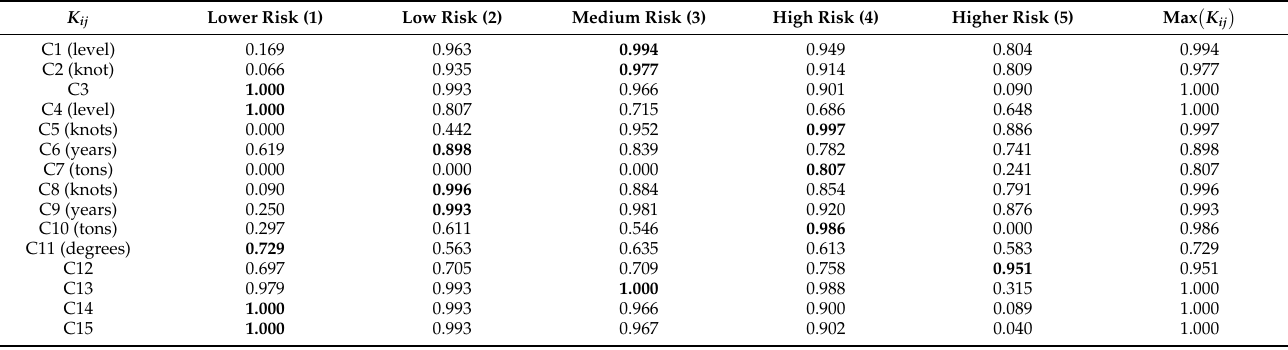
Table 13. Relevance of indicator data of “Z” to each level of the cloud model. (The bold value in the table represents the final risk level of the